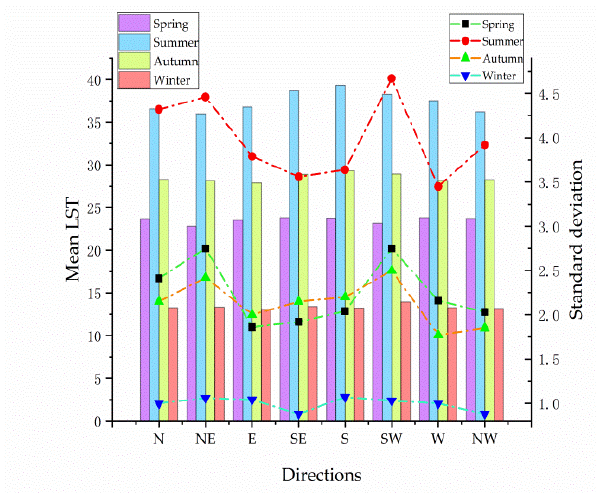
Figure 4. Distribution of mean LST and the variation of LST’s standard deviation